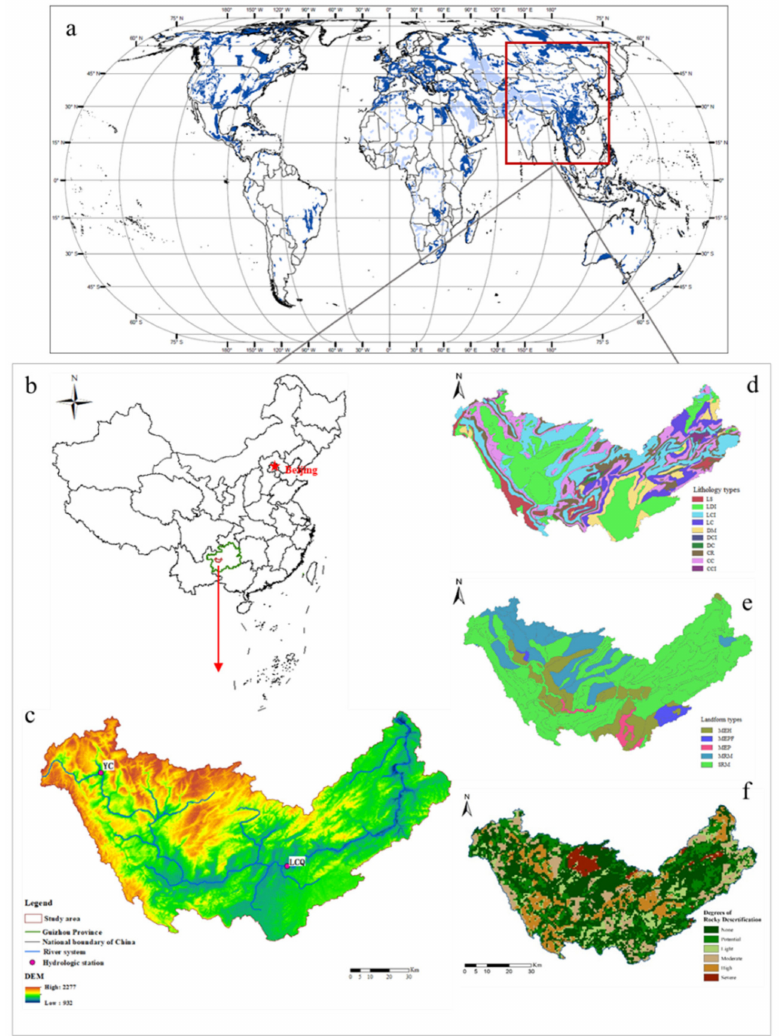
Figure 1. Maps of world karst distribution ( a ) and basic environmental elements ( d , lithology; e , landform; f , rocky desertification) for the study area( c ) in the northwest Guizhou province of China ( b